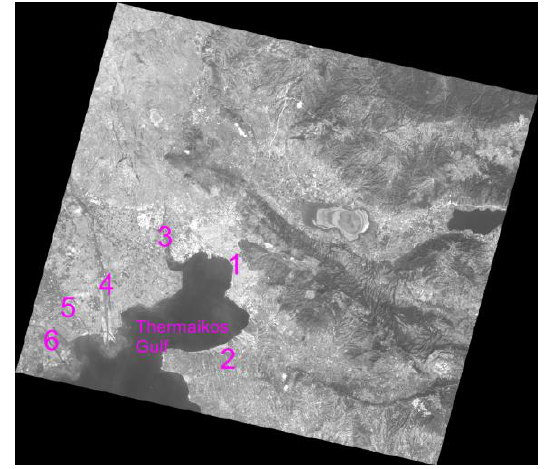
Figure 2. SPOT image of the wider study area Two portions of the above image were selected with the software, subsetting delta area of Gallikos (figure 2, number 3) and Axios (figure 2, number 4) rivers.